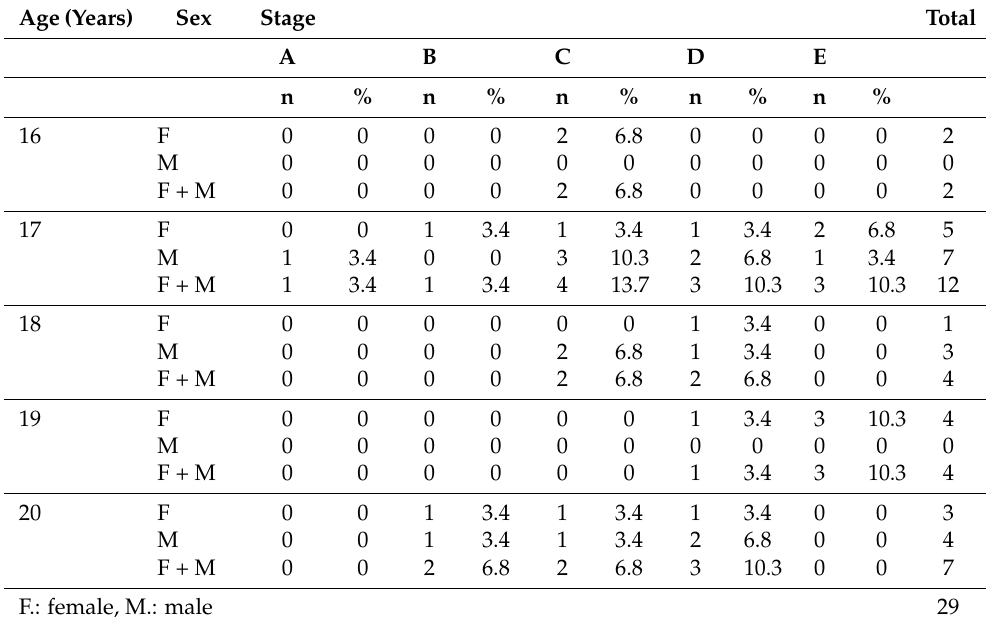
Table 3. Distribution of the MPS maturational stages by age and sex in group of 16- to 20-year-olds.